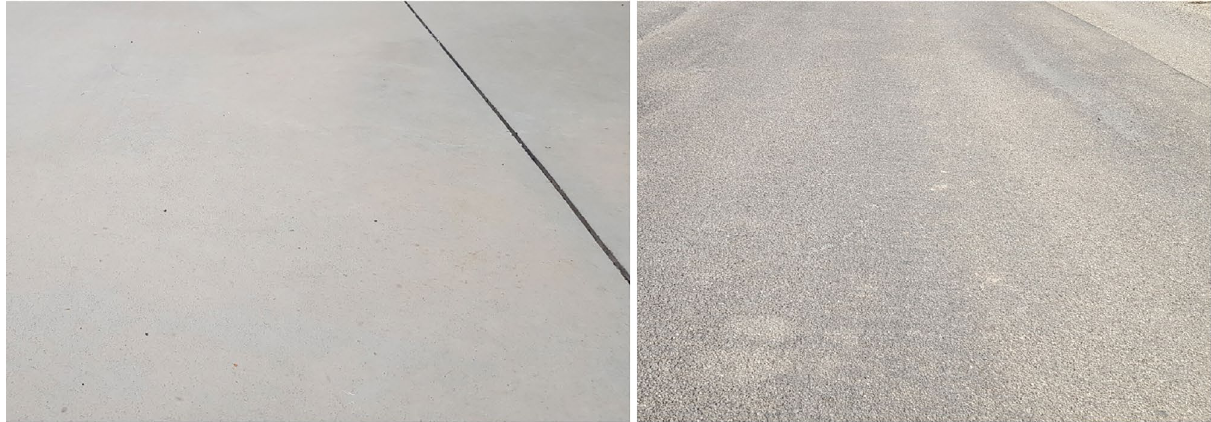
Figure 9. The surfaces used for this research study: concrete, on the left, and asphalt, on the right.